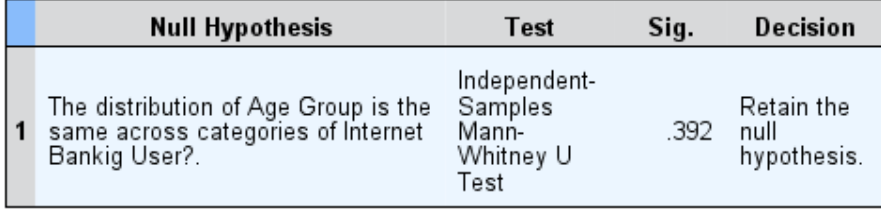
Figure 1. Independent Samples Mann-White U Test for non-parametric test age group across internet banking users. Source: Author's, using SPSS 22